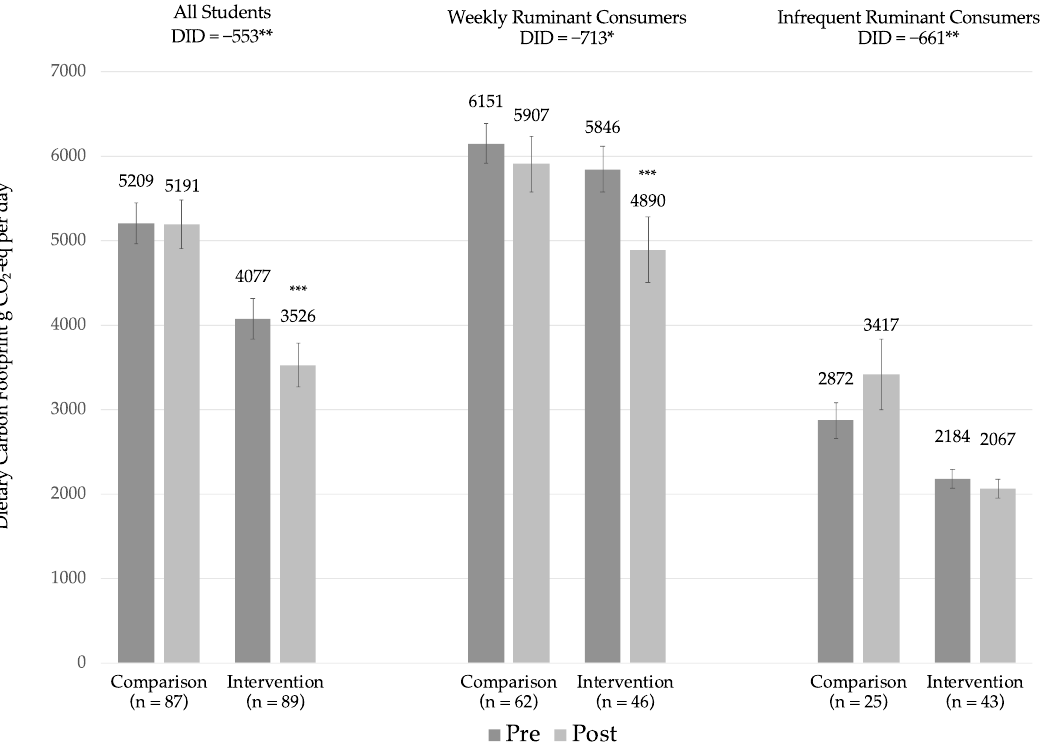
Figure 1. Pre and post daily dietary carbon footprint (g CO 2 -equivalent) by study group for all students, weekly ruminant consumers at baseline, and infrequent ruminant consumers at baseline. Note: Weekly consumers defined as those who reported consuming ruminant meat (beef / lamb) at least once / week at baseline. Infrequent consumers defined as those who reported consuming ruminant meat less than once / week at baseline. Within group pre-post changes tested using Wilcoxon signed rank tests. Di ff erence-in-di ff erences (DID) analysis of pre-post changes between groups tested using one-sided t-tests. * p < 0.10, ** p < 0.05, *** p < 0.01; error bars represent 95% confidence intervals.